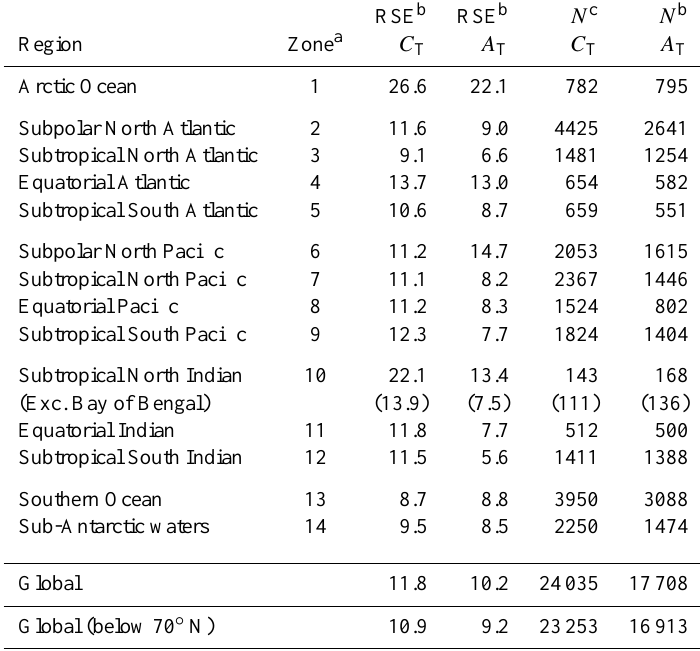
Table 6. Regional and global SOMLO skill evaluation (see supplementary Fig. F2 for map of spatial